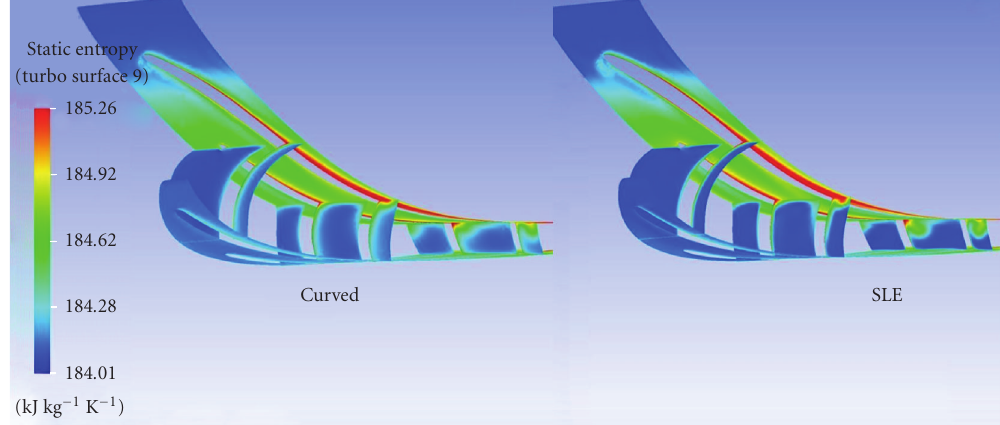
Figure 9: Spanwise contour plots of static entropy at three constant streamwise locations at flow factor of 0.0713.